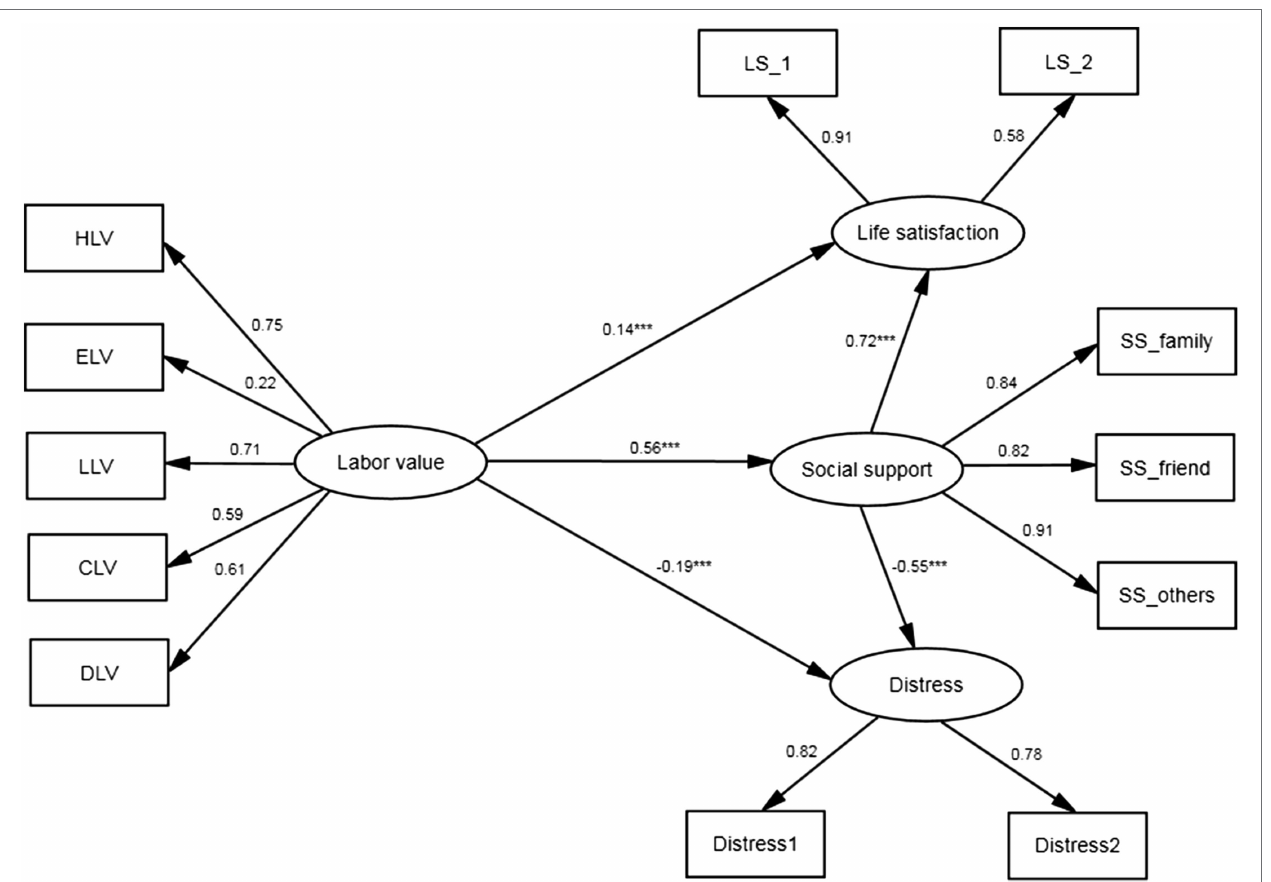
FIGURE 1 | HLV, honest labor value; ELV, equal labor value; LLV, love labor value; CLV, cherishing labor value; DLV, distribution labor value; LS, life